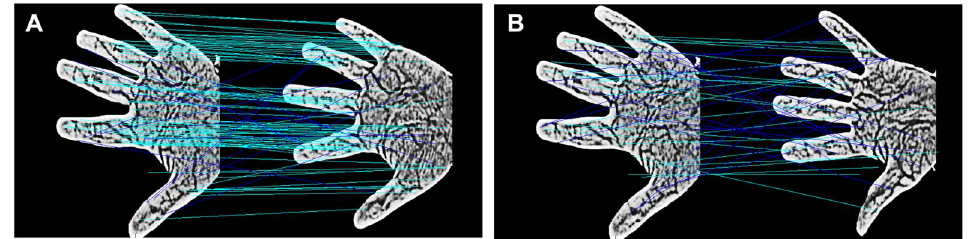
Figure 7. Matching results of the RootSIFT algorithm. (a) Intra-group matching; (b) Inter-group matching.